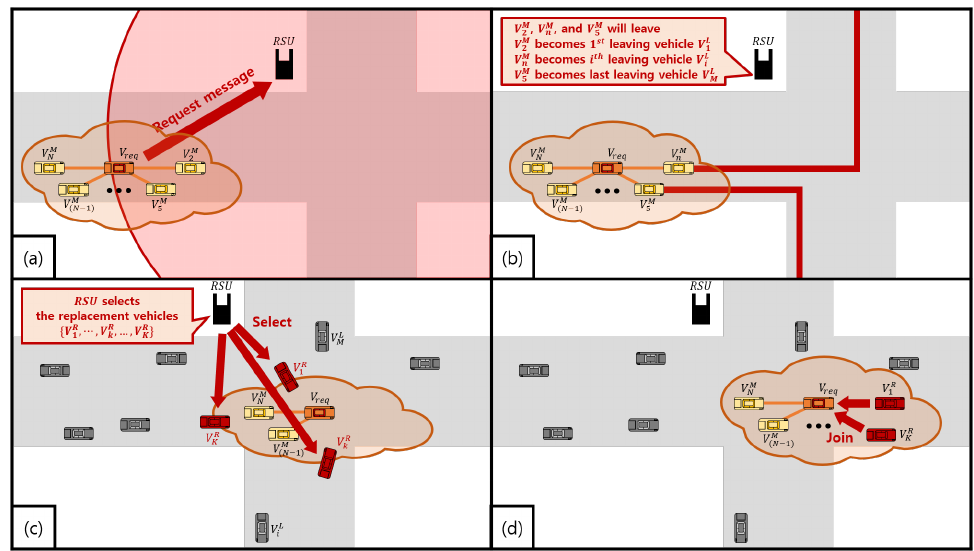
Figure 1. The network model and the overview of the proposed schemes: ( a ) the vehicular cloud enters an intersection, ( b ) RSU determines leaving vehicles, ( c ) RSU selects the replacement vehicles and ( d ) the vehicular cloud is